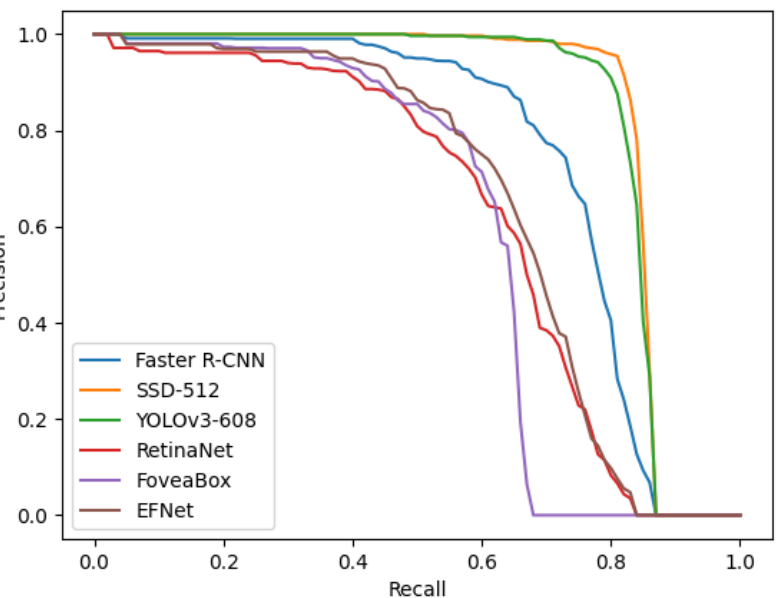
Figure 10. The PR curves of category basketball court for comparative methods on DIOR. These curves are the different IoU s between predicted boxes and ground-truths.